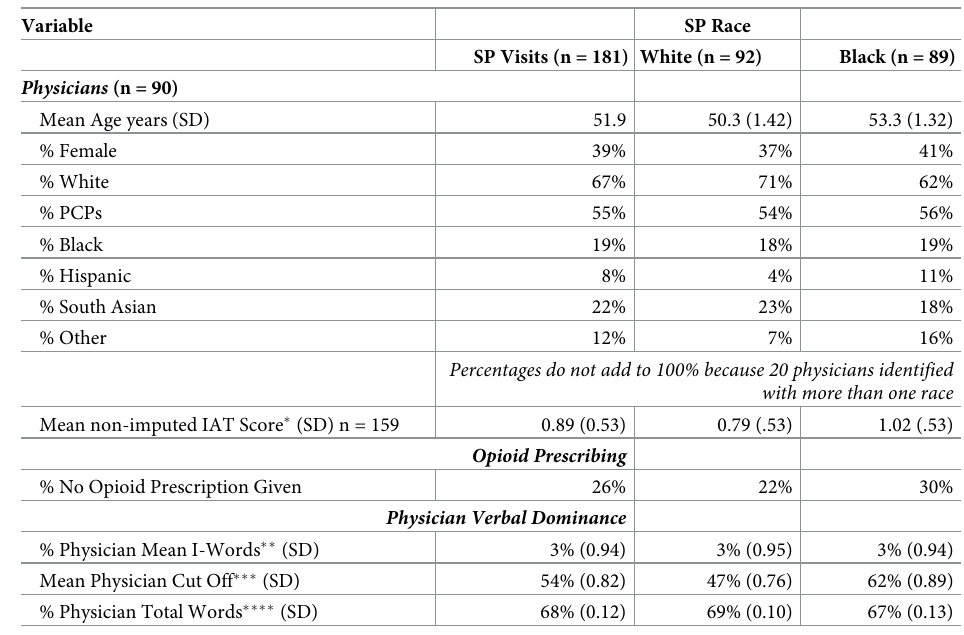
Table 1. Physician characteristics by the race of the